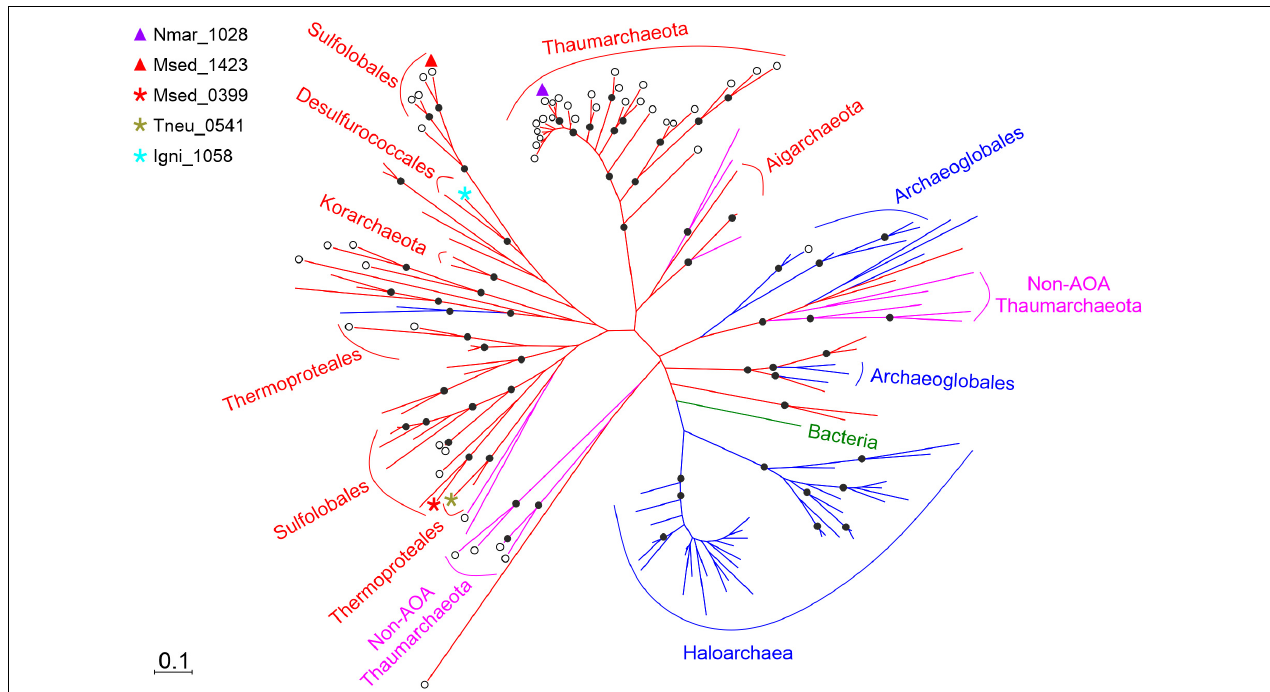
FIGURE 4 | Phylogenetic tree of ( S )-3-hydroxybutyryl-CoA dehydrogenase Nmar_1028. The sequences are marked as following: purple triangle, Nmar_1028; red triangle, Msed_1423; red star, Msed_0399; olive star, Tneu_0541 (from Pyrobaculum neutrophilum ); turquoise star, Igni_1058 (from Ignicoccus hospitalis ); (cid:13) , dehydrogenase; without (cid:13) , fusion protein; 80 sequences from TACK group in red, 15 sequences from non-AOA Thaumarchaeota in fuchsia, 49 sequences from Euryarchaeota in blue, 1 sequence from bacteria in green. The scale bar represents a difference of 0.1 substitutions per site. The percentage bootstrap values for the clade of this group were calculated in 1000 replications. Only values above 70% are shown (as